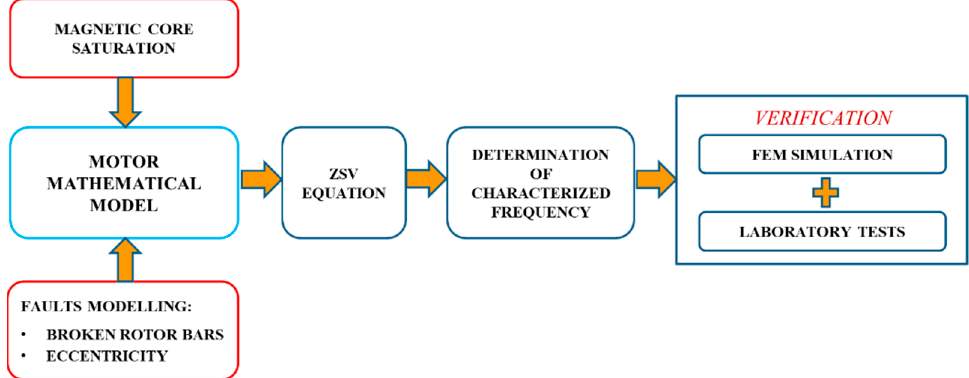
Figure 1. Diagram of the workflow for the tests and result validation.